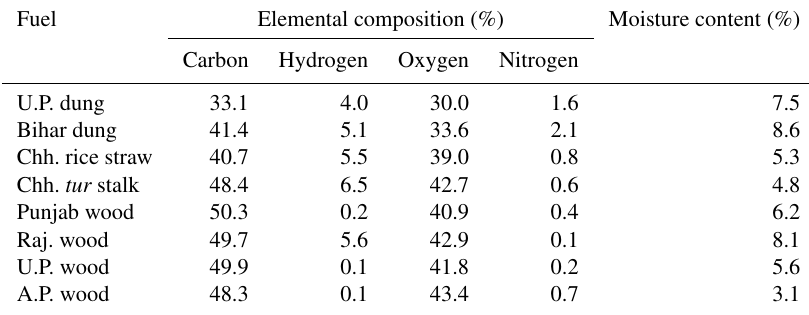
Table 1. Elemental composition and moisture content of the biomass fuels in this study. Fuel Elemental composition (%) Moisture content (%) Carbon Hydrogen Oxygen Nitrogen U.P. dung 33.1 Bihar dung 41.4 Chh. rice